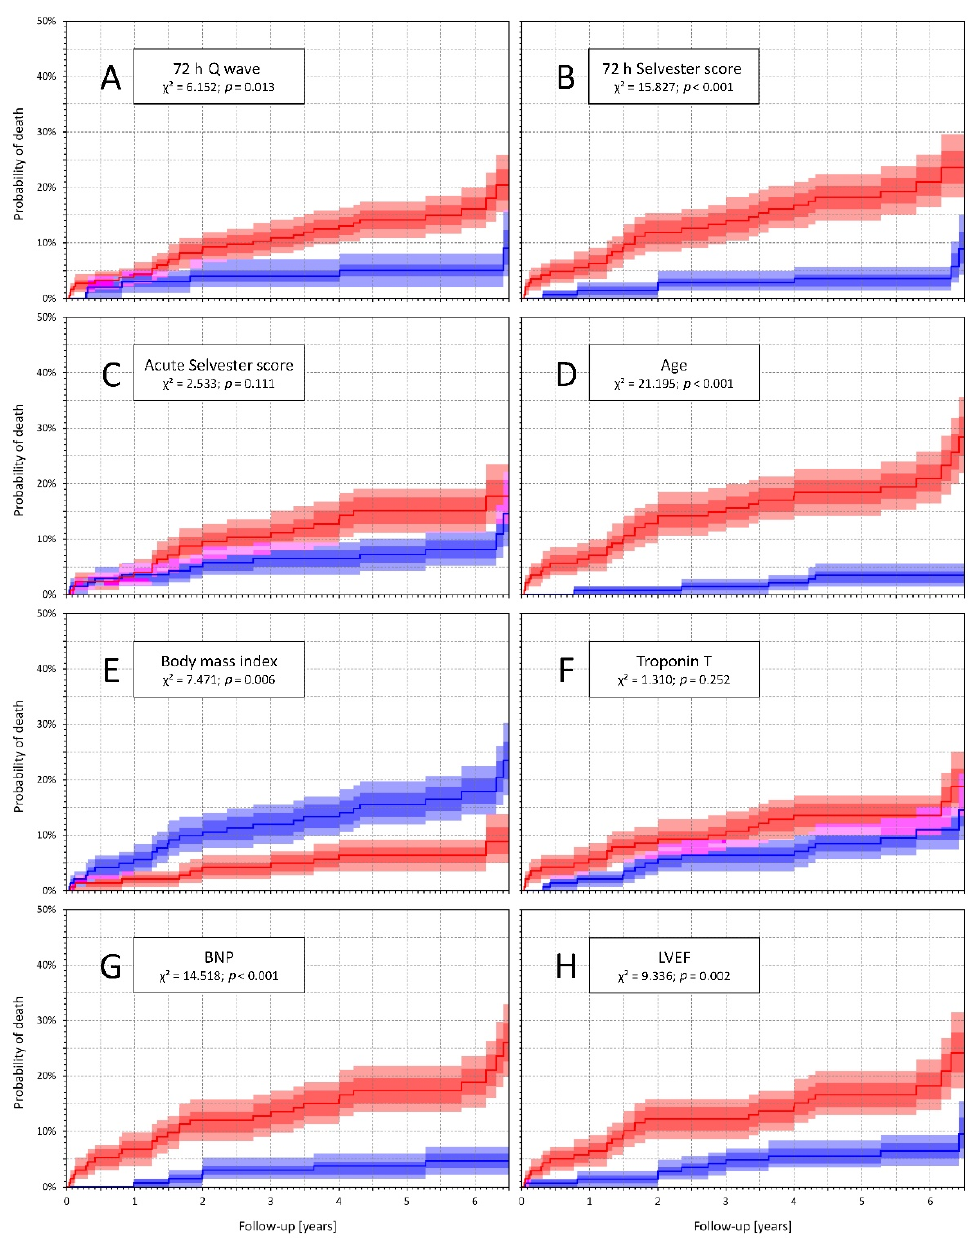
Figure 1. Kaplan–Meier analysis of probability of death in study patients. The panels ( A – C ) show comparisons of patients with (red line) and without (blue line) the presence of the following: panel ( A )—pathologic 72 h Q wave; panel ( B )—72 h Selvester score ≥ 6; panel ( C )—acute Selvester score ≥ 6; panels ( D – H ) show differences according a value of a particular variable above (red line) and below (blue line) the median of the complete population: panel ( D )—age; panel ( E )—body mass index (BMI); panel ( F )—troponin T (TnT); panel ( G )—brain natriuretric peptide (BNP); panel ( H )—ejection fraction of left ventricle (LVEF). In all panels, inter-quartile ranges are shown as the darker areas and 90% confidence intervals as the lighter areas.